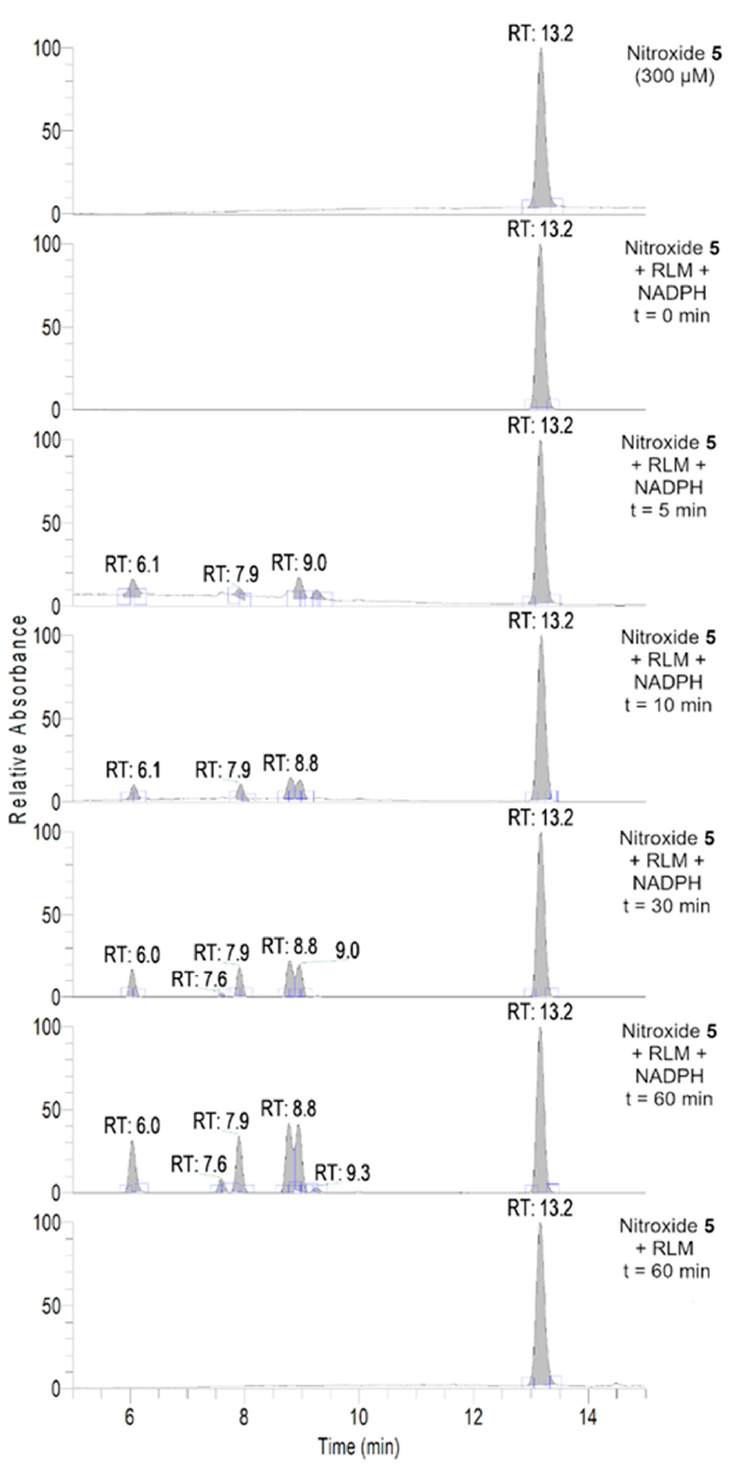
Figure 6. Total scan UV-Vis chromatograms of incubations of nitroxide 5 (300 µ M) with RLM (30 µ M of P450) with and without NADPH (2 mM) in potassium phosphate buffer (0.1 M, pH 7.4) in the presence of oxygen at 21 ◦ C at different time points. Samples were prepared and analyzed as described in the experimental